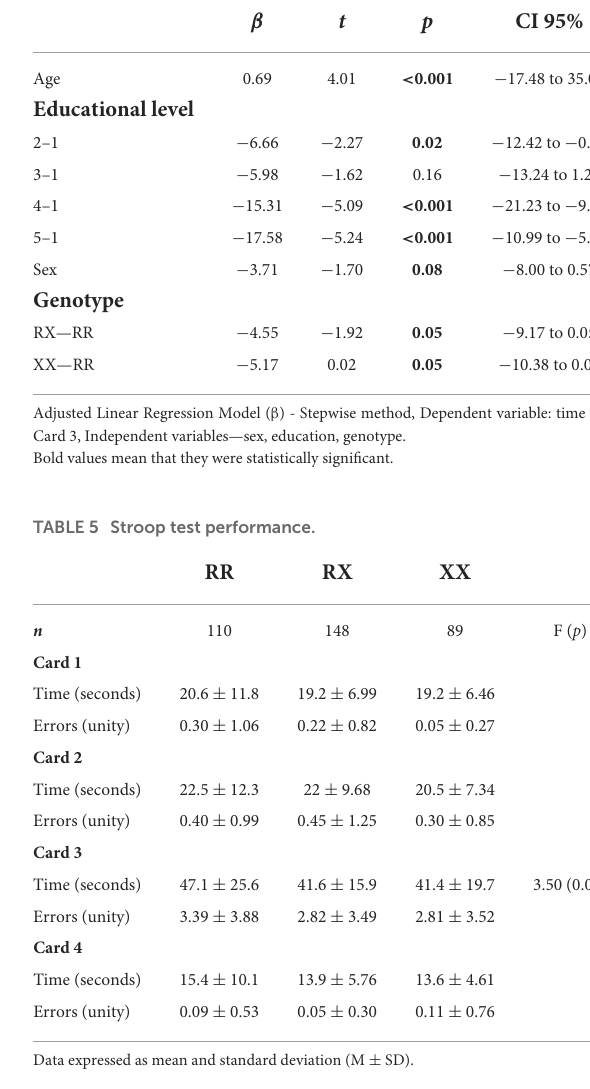
TABLE 4 Predictor factors for executive function in the elderly.